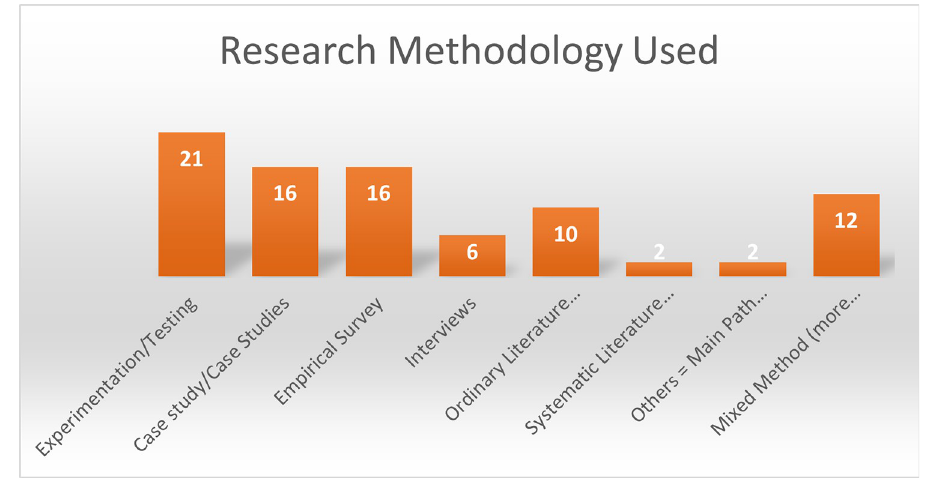
Fig 2. Analysis based on research